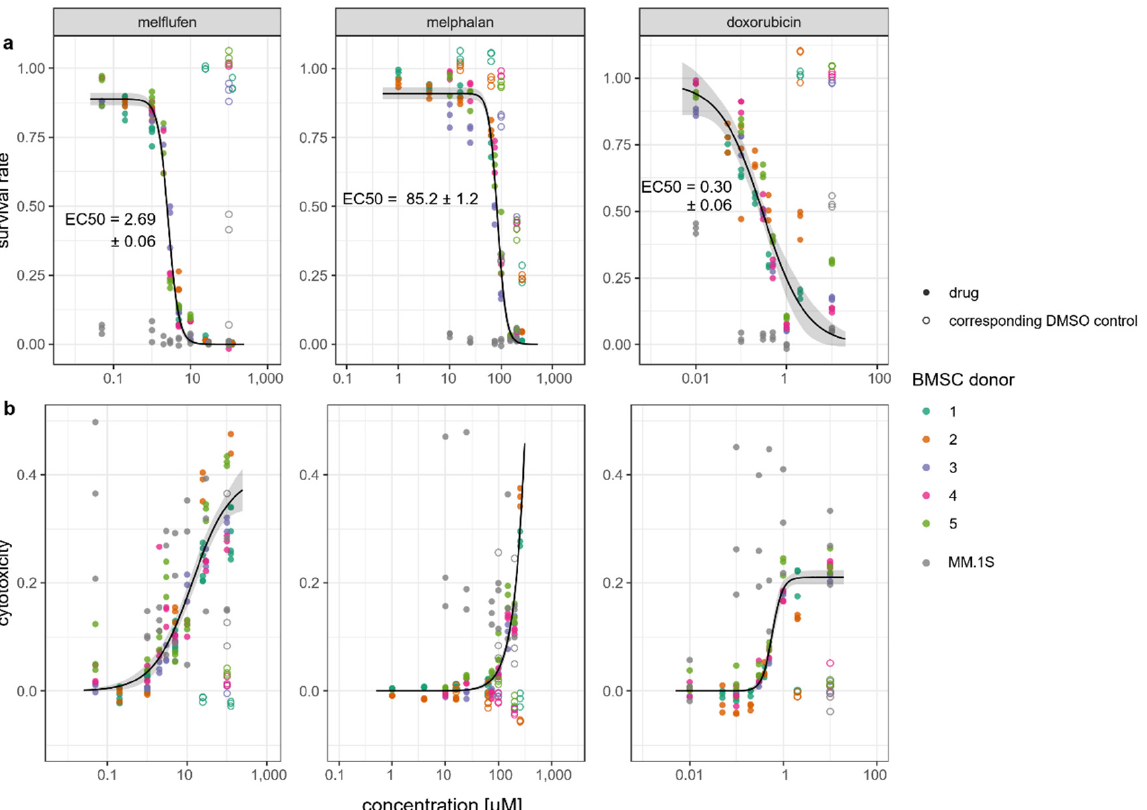
Figure 1. Viability of bone marrow-derived stem/stromal cells (BMSCs) and MM.1S myeloma cells in the presence of drugs. Survival rates ( a ) and cytotoxic response ( b ) of BMSCs and MM.1S myeloma cells after 72 h of culture with melflufen, melphalan and doxorubicin at indicated concentrations relative to control cultures without drugs. Dots represent individual culture wells with a color-coded donor cell line. Open circles indicate dimethylsulfoxide (DMSO) vehicle controls for the indicated drug concentrations. Dose–response curves for BMSCs with confidence interval indicated in gray.